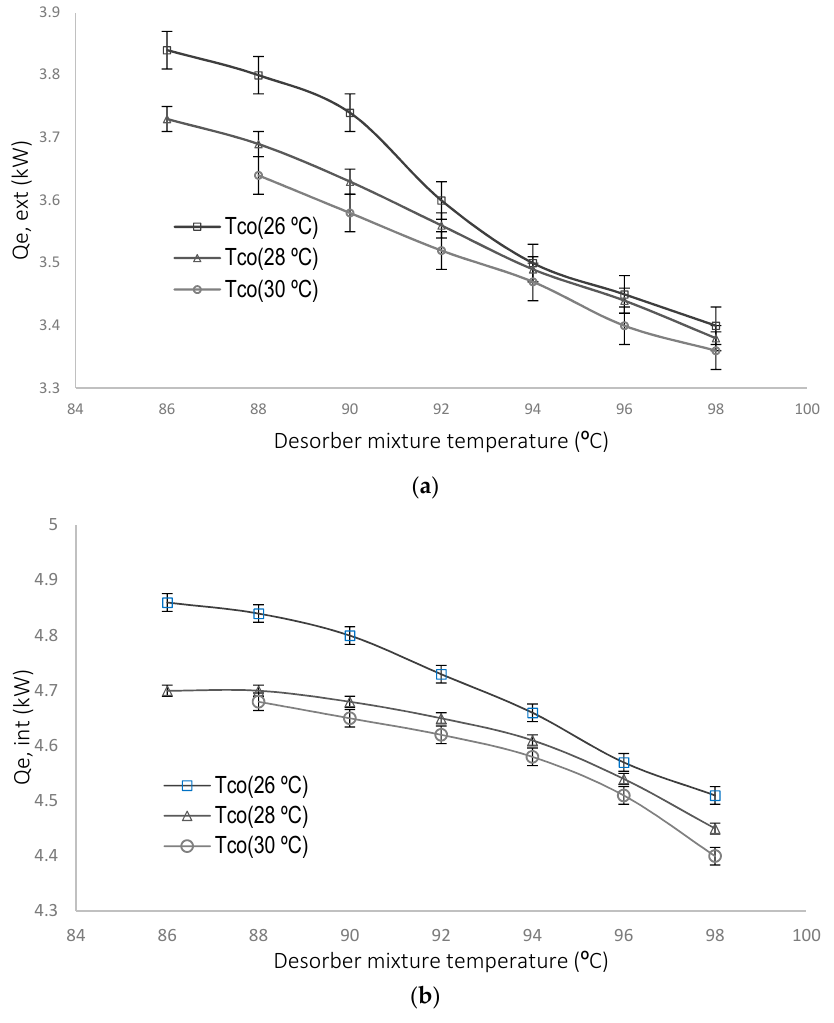
Figure 6. External ( a ) and internal ( b ) evaporator cooling capacity as a function of the heating water temperature at DE for different cooling water temperatures.